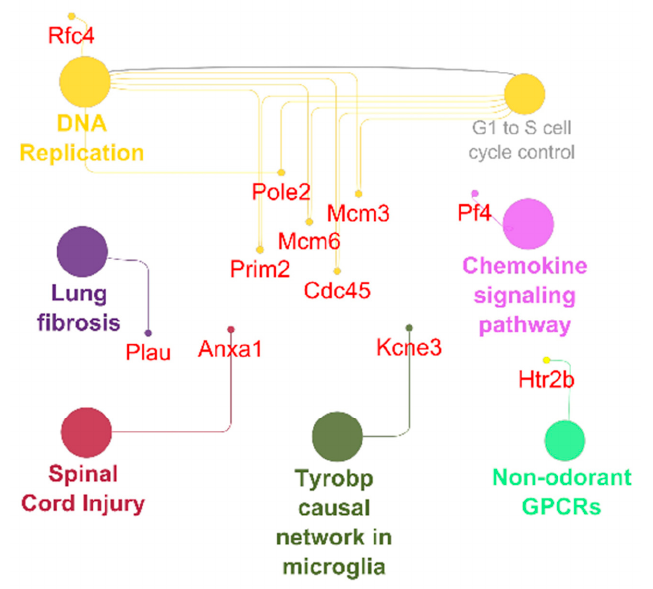
Figure 6. Antiarrhythmic pathways and associated genes in URI-group. High expressed genes (small dots) and pathways (big dots; q ≤ 0.05). Node size-number of genes. Edges-relation based on kappa score 0.6 using experimental data.